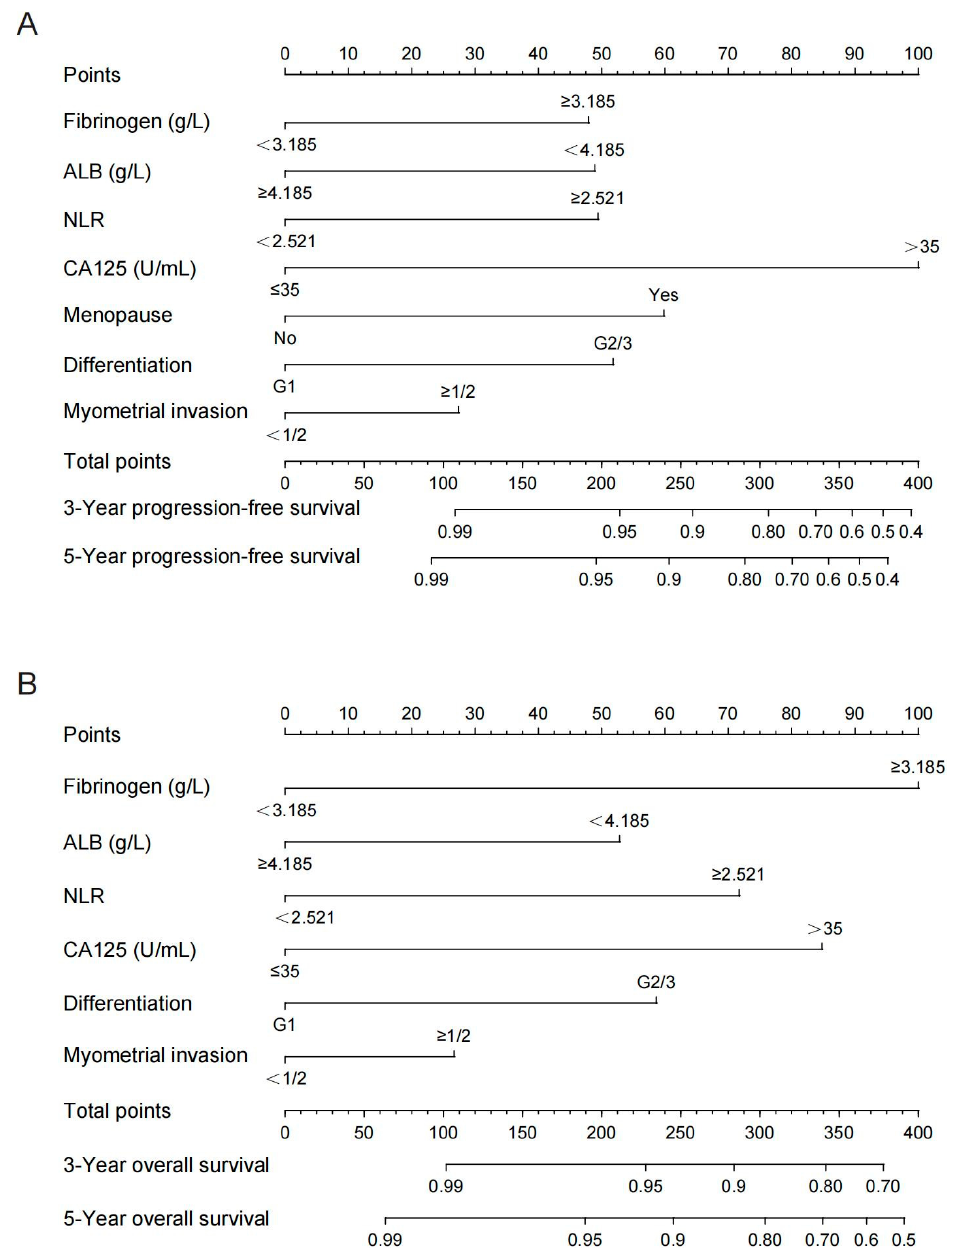
Figure 3. Nomograms for predicting the postoperative PFS ( A ) and OS ( B ) for 3 and 5 years in endometrial patients. ALB, albumin; NLR, neutrophil–lymphocyte ratio; CA125, carbohydrate antigen 125.